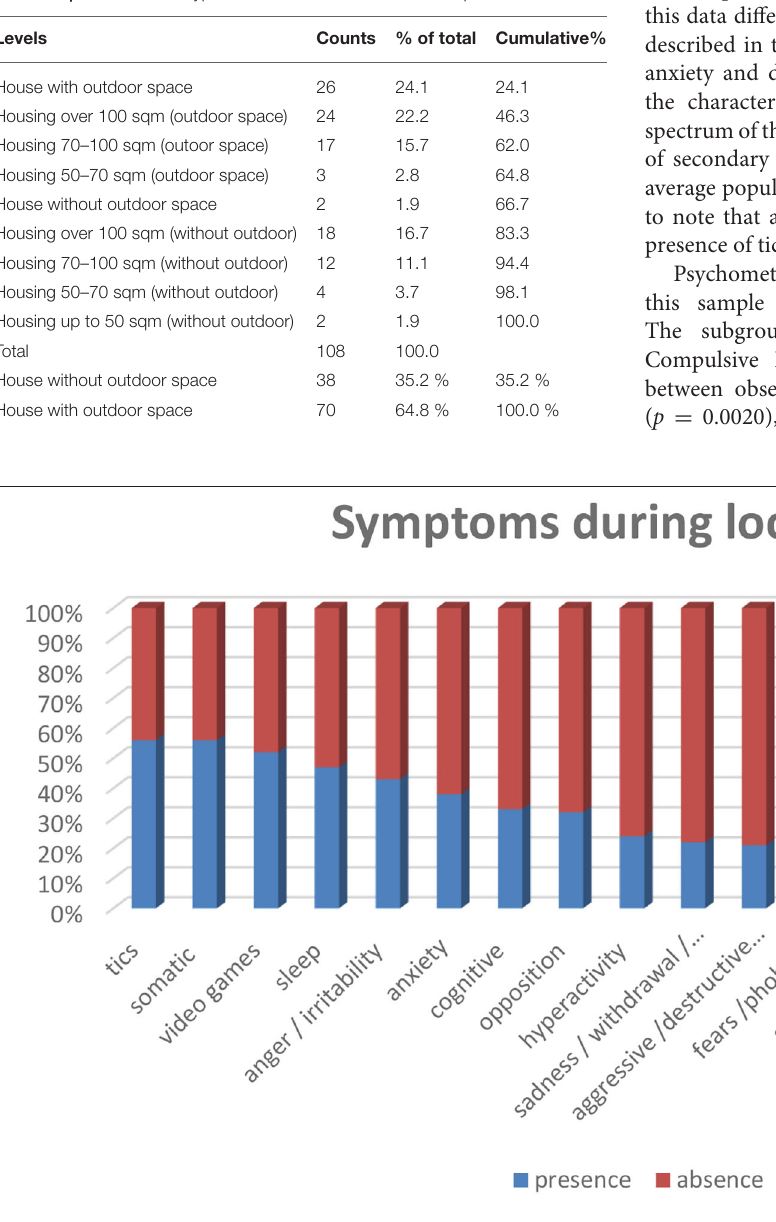
FIGURE 1 | Frequencies of symptoms during the